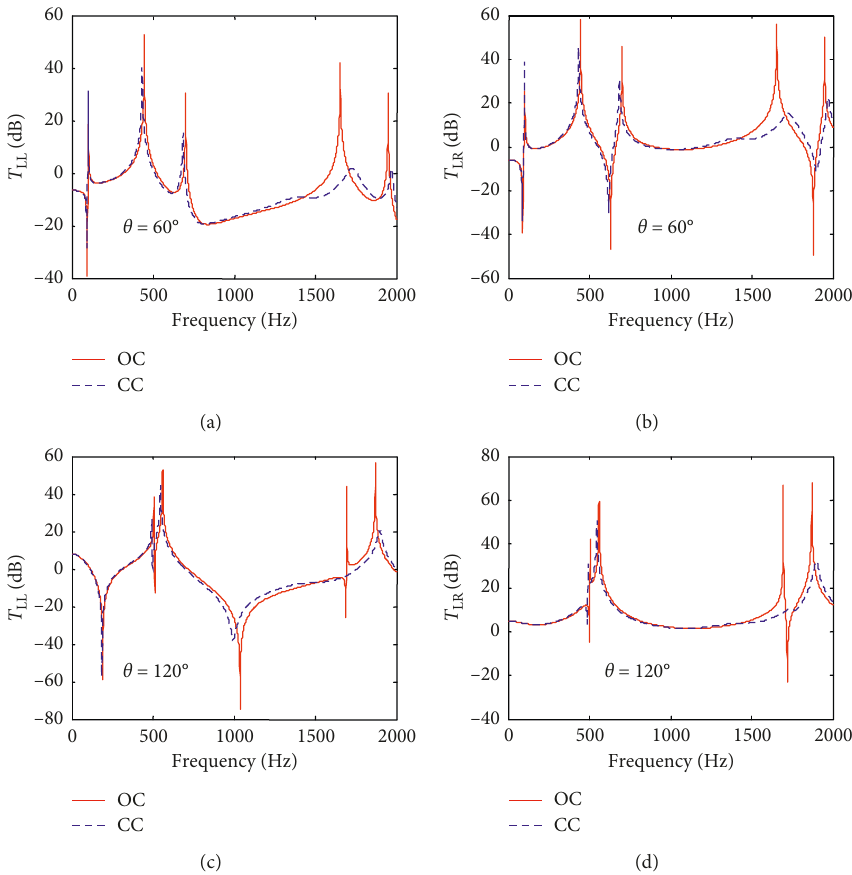
Figure 12: Mode conversion from longitudinal to flexural waves with open circuits (OC) and closed circuits (CC, L � 0.4H and R � 800 Ω